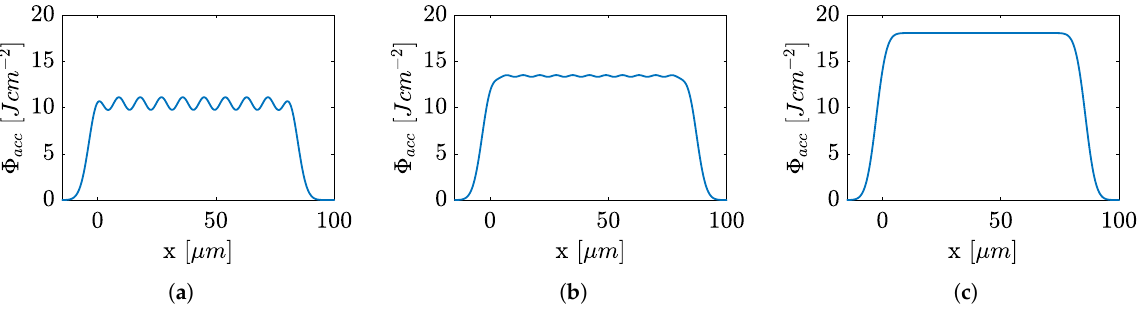
Figure 4. Simulated 2D cumulative fluence in pulse or hatch directions with overlap of ( a ) 35% ( b ) 50% ( c ) 65% for a single pulse fluence of 10Jcm − 2 following